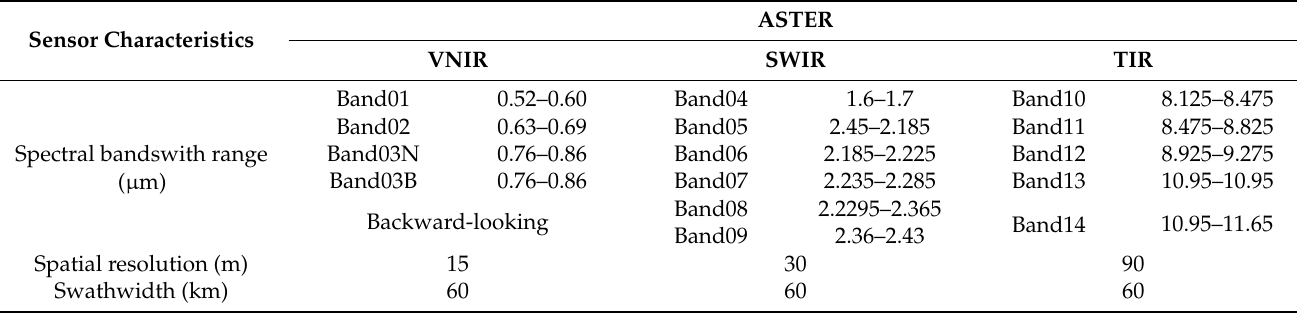
Table 1. Sensor characteristics of ASTER instruments